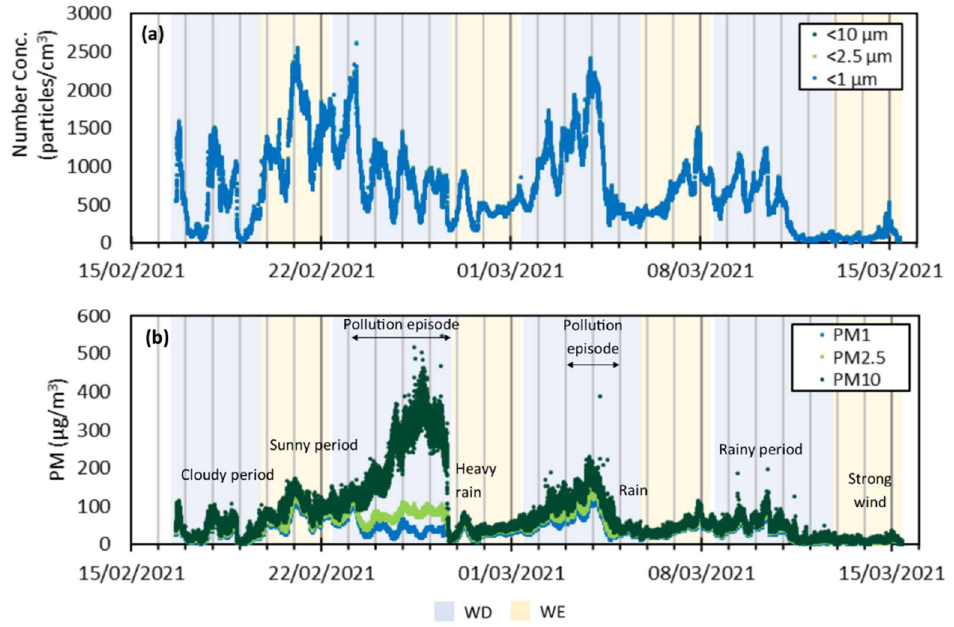
Figure 2. Temporal distribution of particle concentration in air during the sampling period, measured with the particle analyser, in terms of: ( a ) number concentration for different size ranges, and ( b ) PM values.